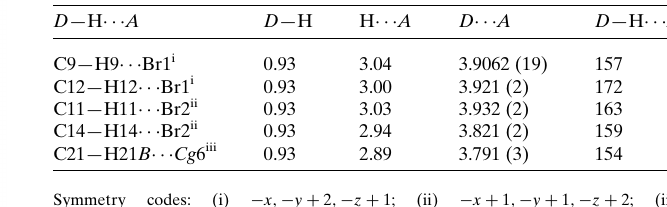
Figure 1 The molecular structure of the title compound, 1 , with the atom labelling. Displacement ellipsoids are drawn at the 30% probability